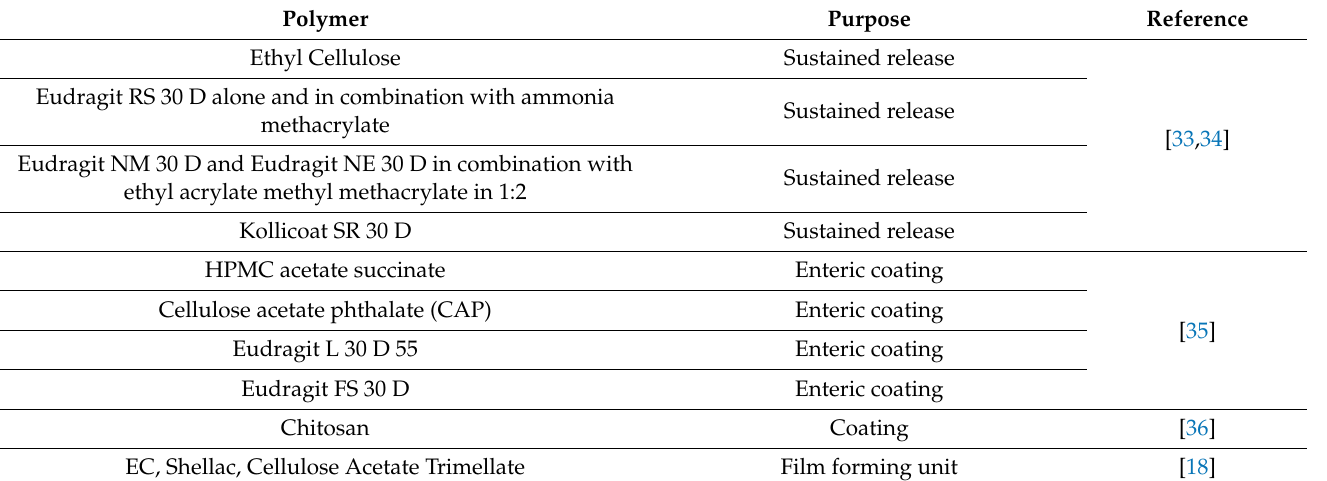
Table 5. Showed the polymers used for modifying drug delivery